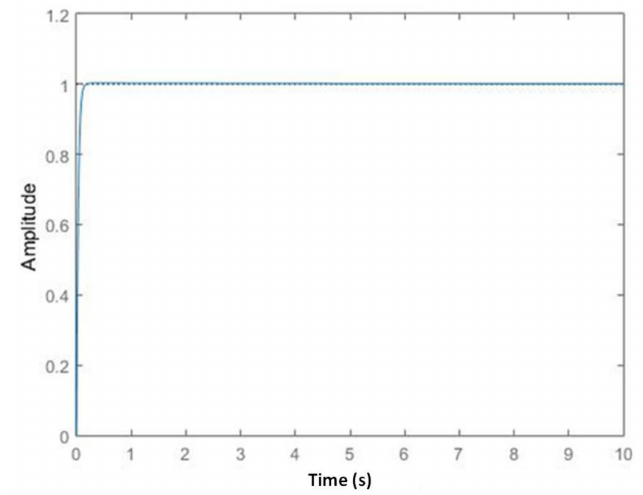
Figure 13. The response of the machining bed system when PID controller is applied. Table 6. Pseudocode for the algorithm (CTA) to reduce computational time.